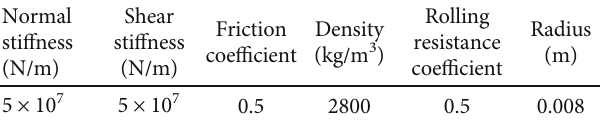
Table 3: Mechanical parameters of the ore